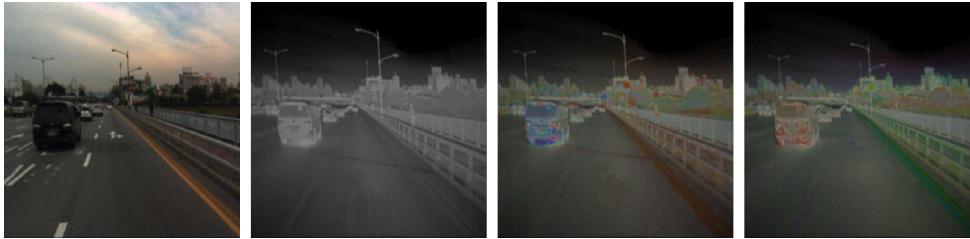
Figure 2. Example input images processed by the YOLOv4 architecture: RGB and thermal images on the left and HST and GST images on the